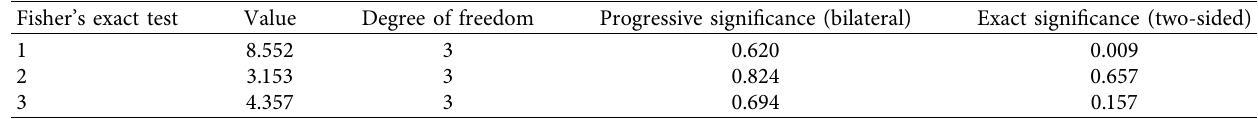
Table 10: Chi-square analysis of foul type and race